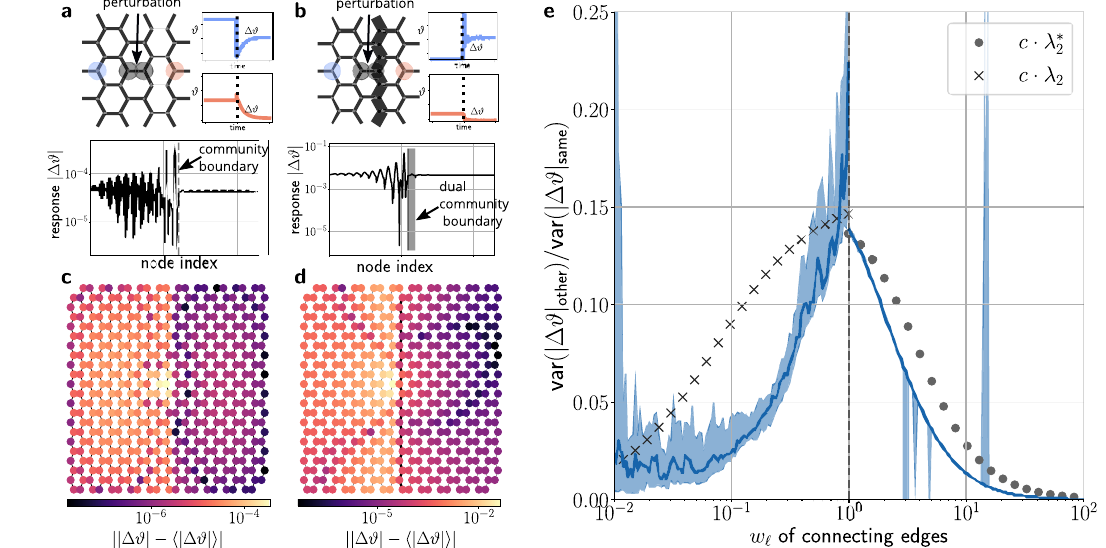
Fig. 7 | Suppression of failure spreading in oscillator networks. a , b We analyze theresponseofanetworkofphaseoscillators(Eq.(20))toalocalizedperturbation. We consider a honeycomb lattice with a a primalcommunity structureinducedby weak connectivity across the community boundary and b a dual community structure induced by strong connectivity along the boundary. After the perturba- tion the oscillators relax back to a phase-locked state with phases shifted by Δ ϑ i . c , d We fi nd that the response ∣ Δ ϑ i ∣ is strongly suppressed in the non-perturbed community. e The overall network response is quanti fi ed by the variance of the